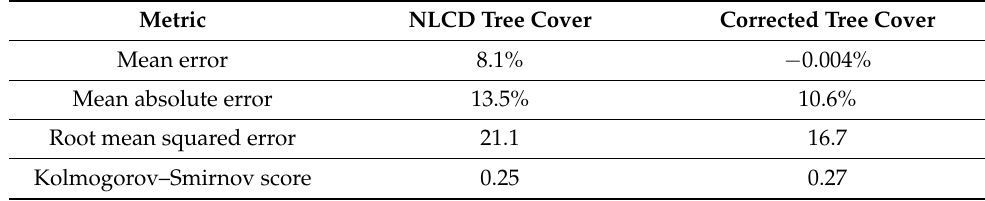
Table 3. Summary predictive model